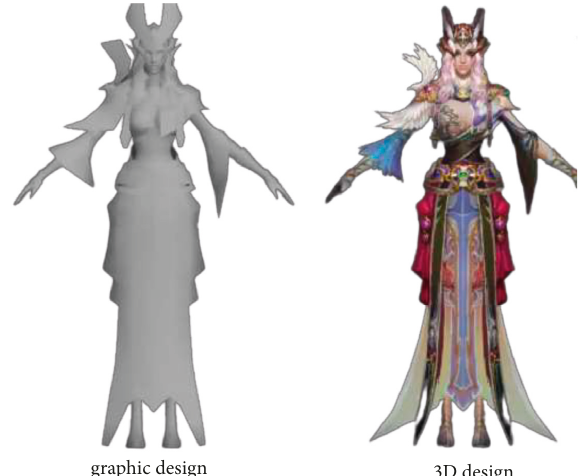
graphic design Figure 5: 3D technology in game character